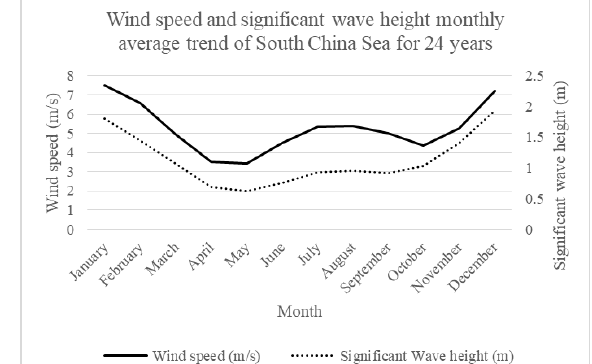
Figure 8. Monthly trend of wind speed and significant wave height for South China Sea.